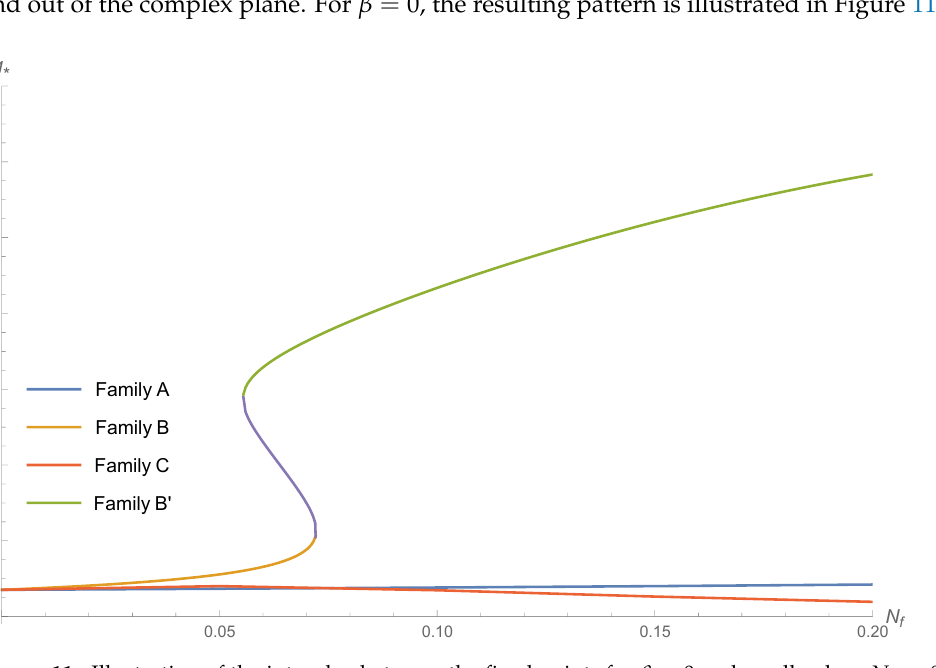
Figure 11. Illustration of the interplay between the fixed points for β = 0 and small values N f < 0.2. Family B (orange line) crosses over into the complex plane upon colliding with a short-lived fixed point given by the purple line. The Family B ’ (green line) extends to arbitrary values of N f . On this basis, we identify the Family B ’ as the “continuation” of Family B to arbitrary large values N f